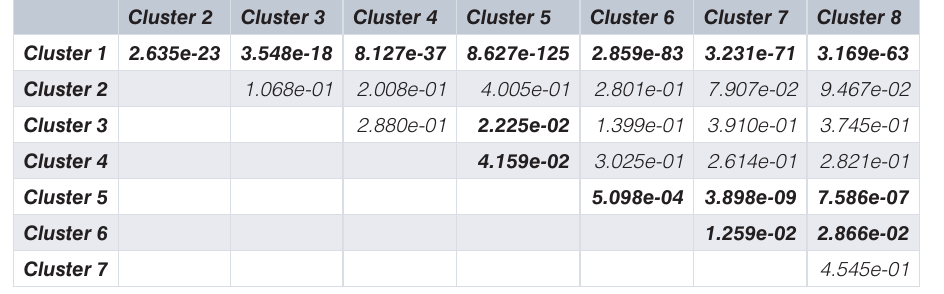
Table 1. p -values of Mann-Whitney U-test for differences in distribution of expression between clusters. Tests showing significant difference ( p ≤ 0.05) are presented in bold face.